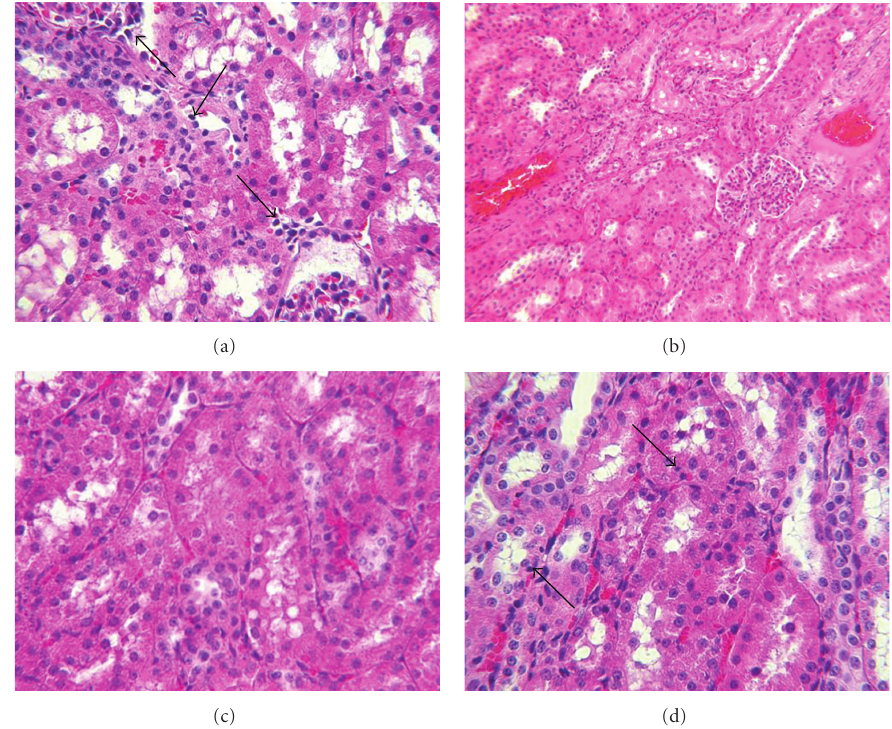
Figure 2: Histopathology of kidneys from a pig that received WBI 72 h previously of 700 cGy and a further 800 cGy with both kidneys shielded (H&E, magnification × 100). (a) A few passenger leukocytes can be detected in the interstitium (arrows). (b) Congestion is present in some peritubular blood vessels. (c) Tubular vacuolization and cloudy swelling of tubular cells are present. (d) Tubular epithelial apoptosis can be detected